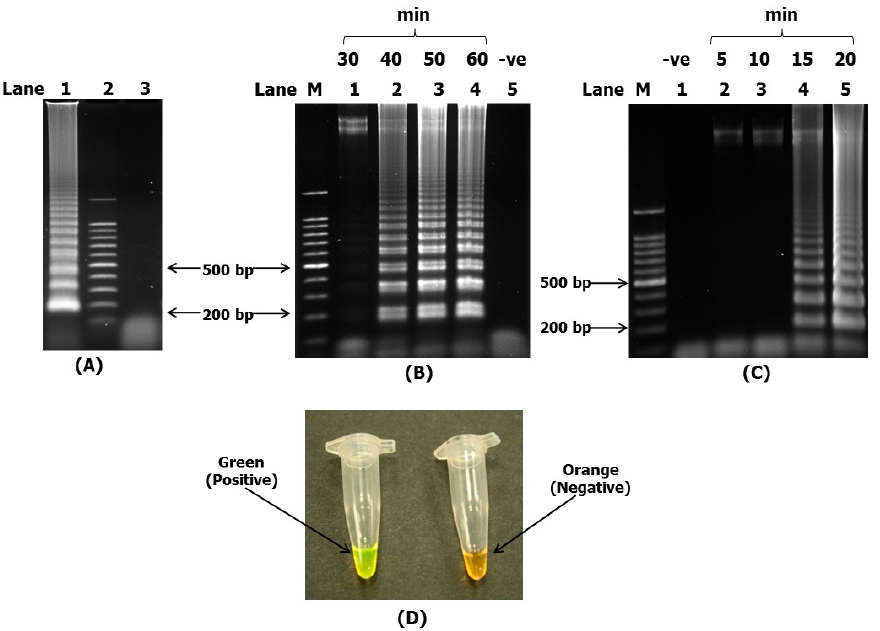
Figure 2. Gel electrophoresis of the LAMP assay and visualization with SYBR Green ( A ) An opti- mized LAMP protocol was developed for subsequent downstream tests, lane 1: V. harveyi ( genomic DNA), lane 2: 100 bp DNA ladder, lane 3: negative control (distilled water). ( B ) Reaction mixture without loop primers, lane M: 100 bp DNA ladder, lane 5: negative control (distilled water); the reaction time of LAMP is indicated on the top of each lane. ( C ) Reaction mixture with loop primers, lane M: 100 bp DNA ladder, lane 1: negative control (distilled water); the reaction time of LAMP is indicated on the top of each lane. All products were analyzed by electrophoresis on a 1.5% agarose gel and stained with ethidium bromide. ( D ) Visual appearance of LAMP coupled with SYBR Green. Positive sample (green) and negative sample (orange).